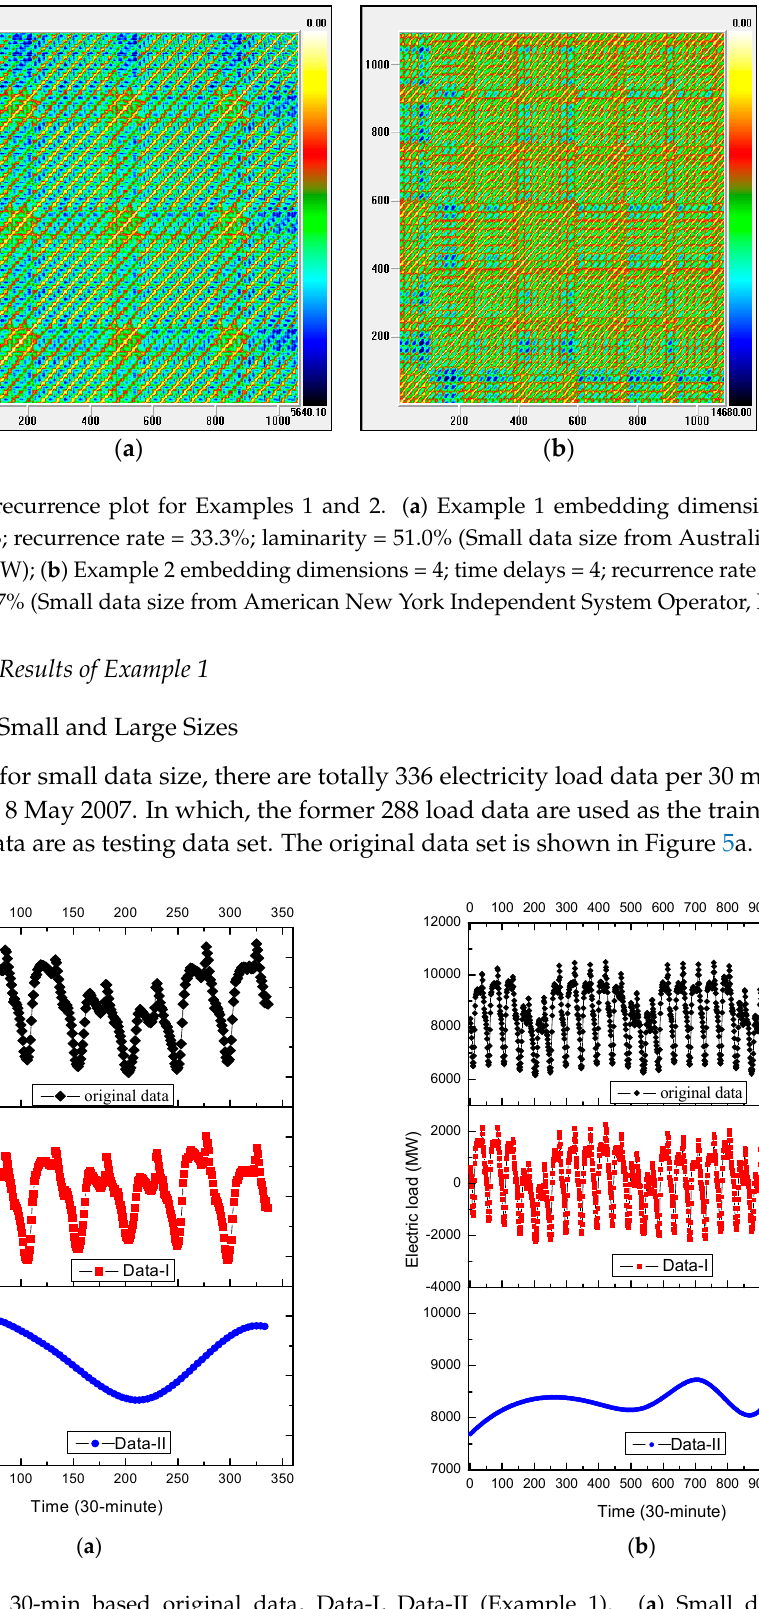
Figure 5. The 30-min based original data, Data-I, Data-II (Example 1). ( a ) Small data size (2–8 May 2007); ( b ) Large data size (2–24 May 2007).